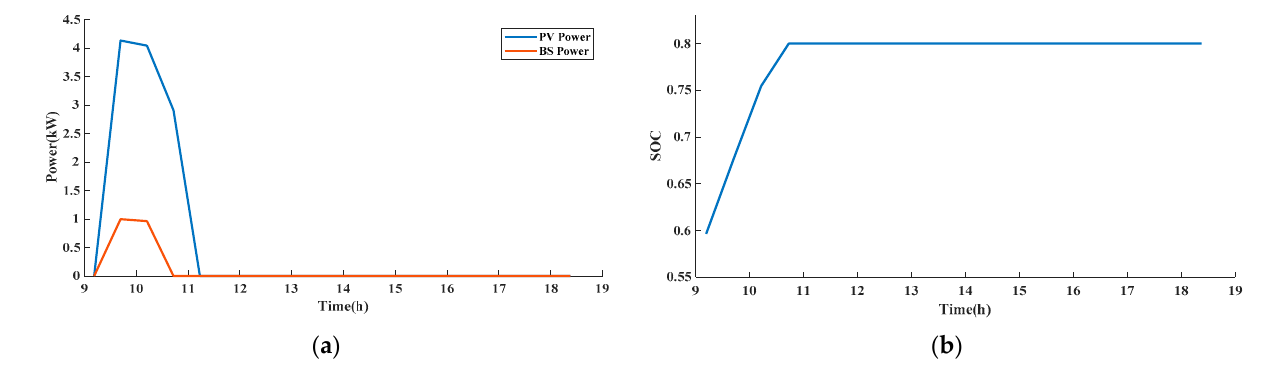
Figure 14. Typical charging curve of EV. ( a ) charging power; ( b ) SOC.